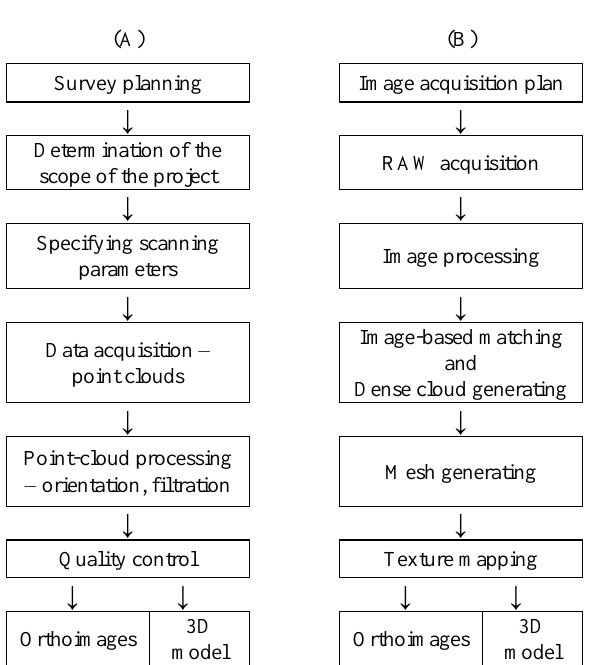
Figure 1. Diagram of the technological process for: A) laser scanning; B) dense digital image matching (Van Genechten, 2008; Gianolio,